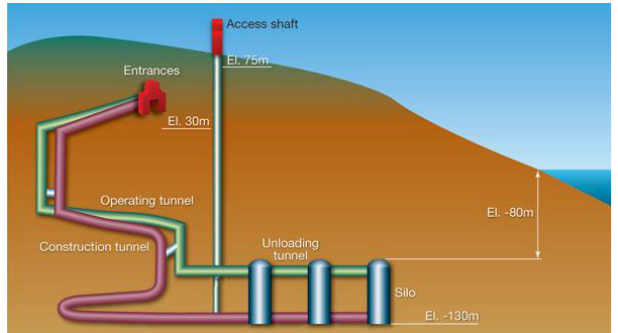
Figure 2. Layout of LILW disposal